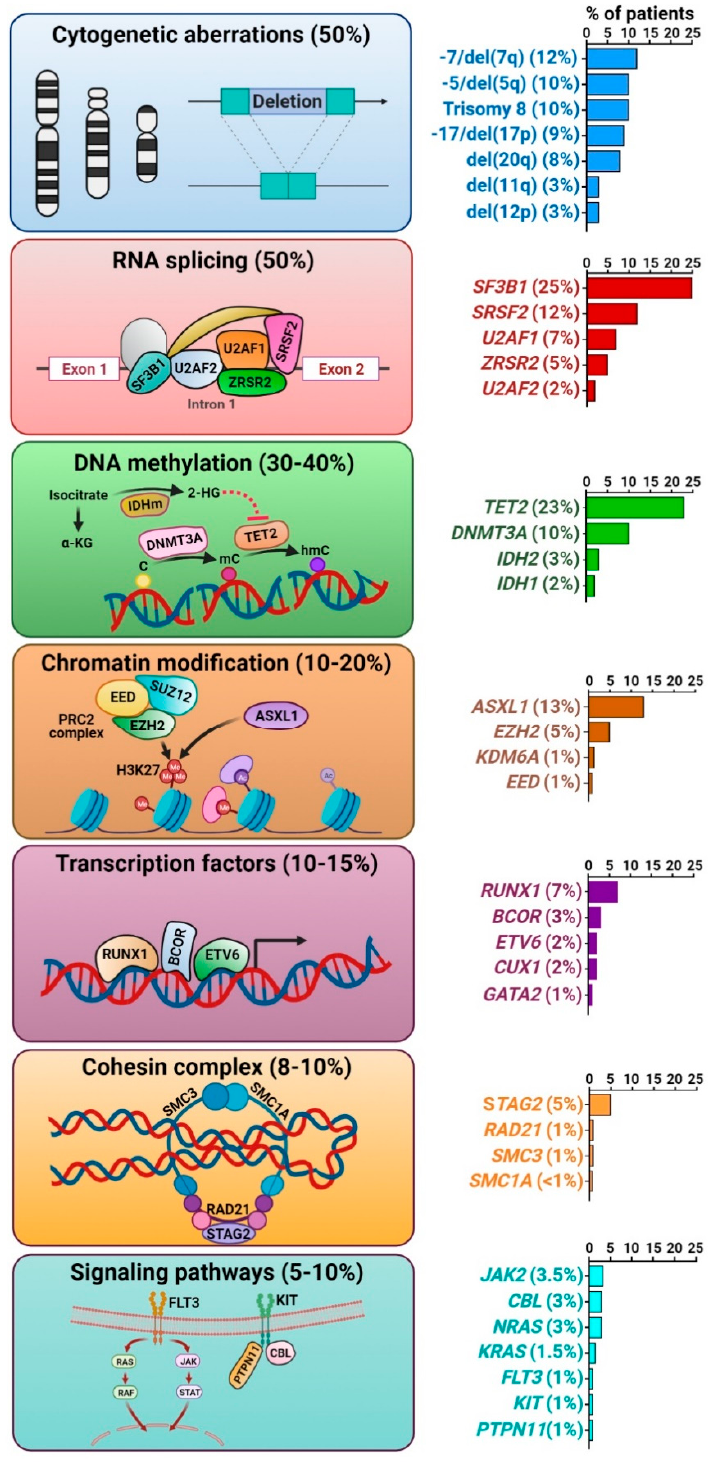
Figure 1. Somatic mutation landscape in myelodysplastic syndromes. Schemas highlight individual groups of mutations, and the associated bar graphs on the right provide the mutation percentages.